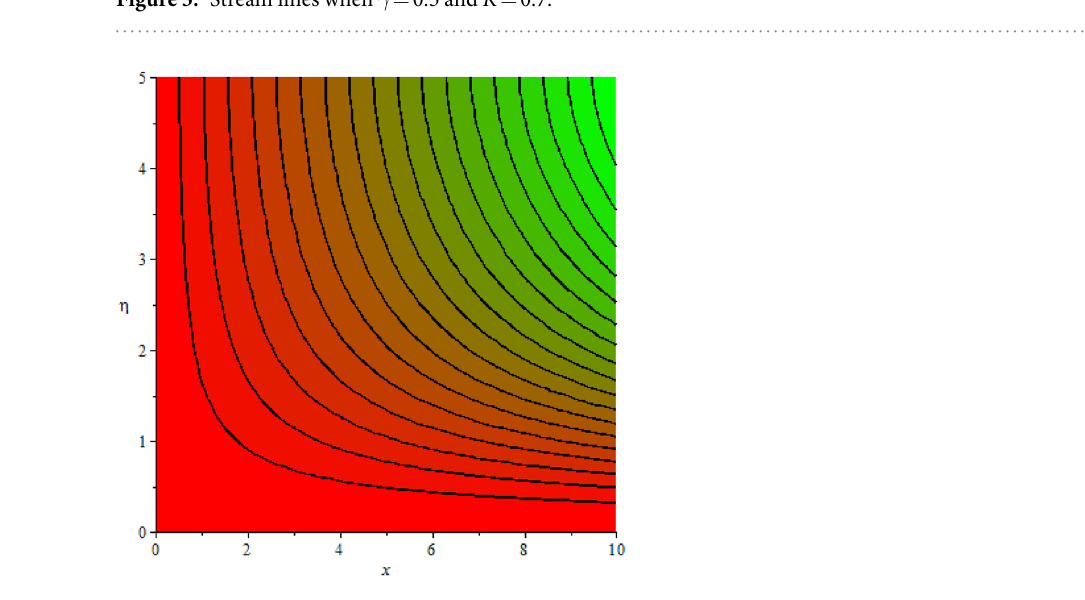
Figure 4. Stream lines when γ = 0.5 and K = 0.0.